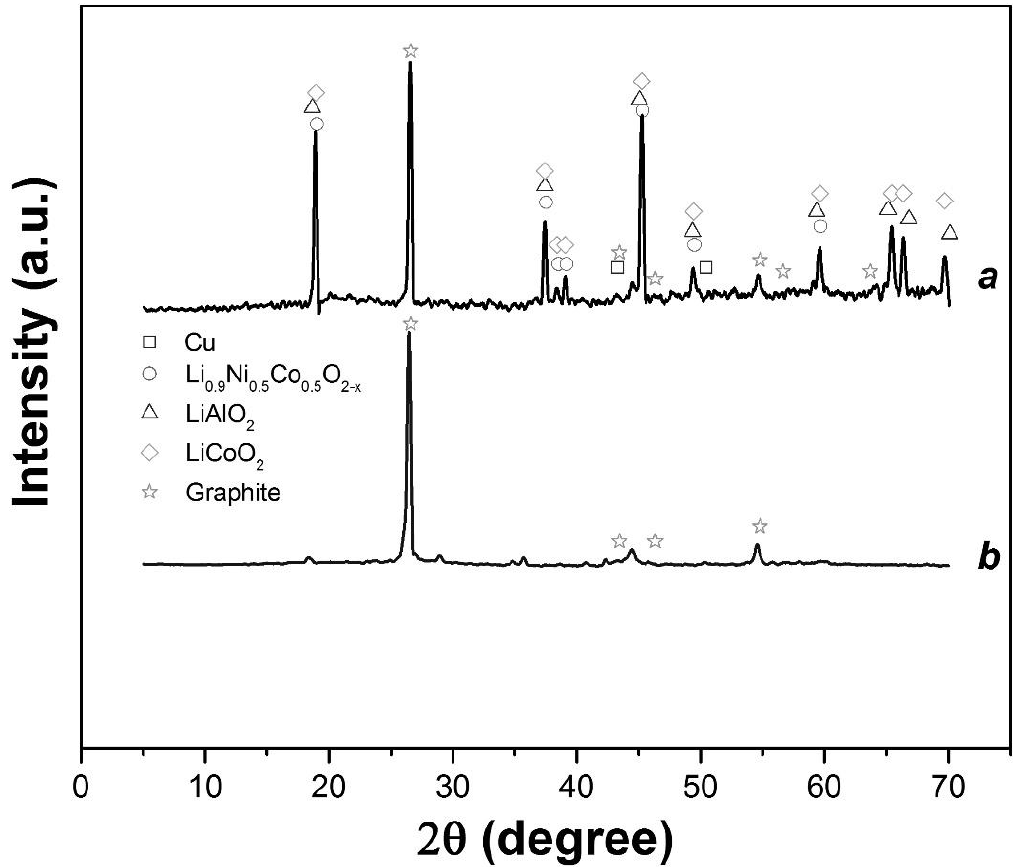
Figure 6. Spectra of X-ray diffraction analysis before ( a ) and after ( b ) leaching. Al 2 O 3 PDF Card #00-010-0173, Cu PDF Card #00-004-0836, C (graphite) PDF Card #00-026-1079, Li 0.9 Ni 0.5 Co 0.5 O 2−x PDF Card #00-050-0509, LiAlO 2 PDF Card #00-044-0224, and LiCoO 2 PDF Card #00-050-0653. PDF = Powder Diffraction File.